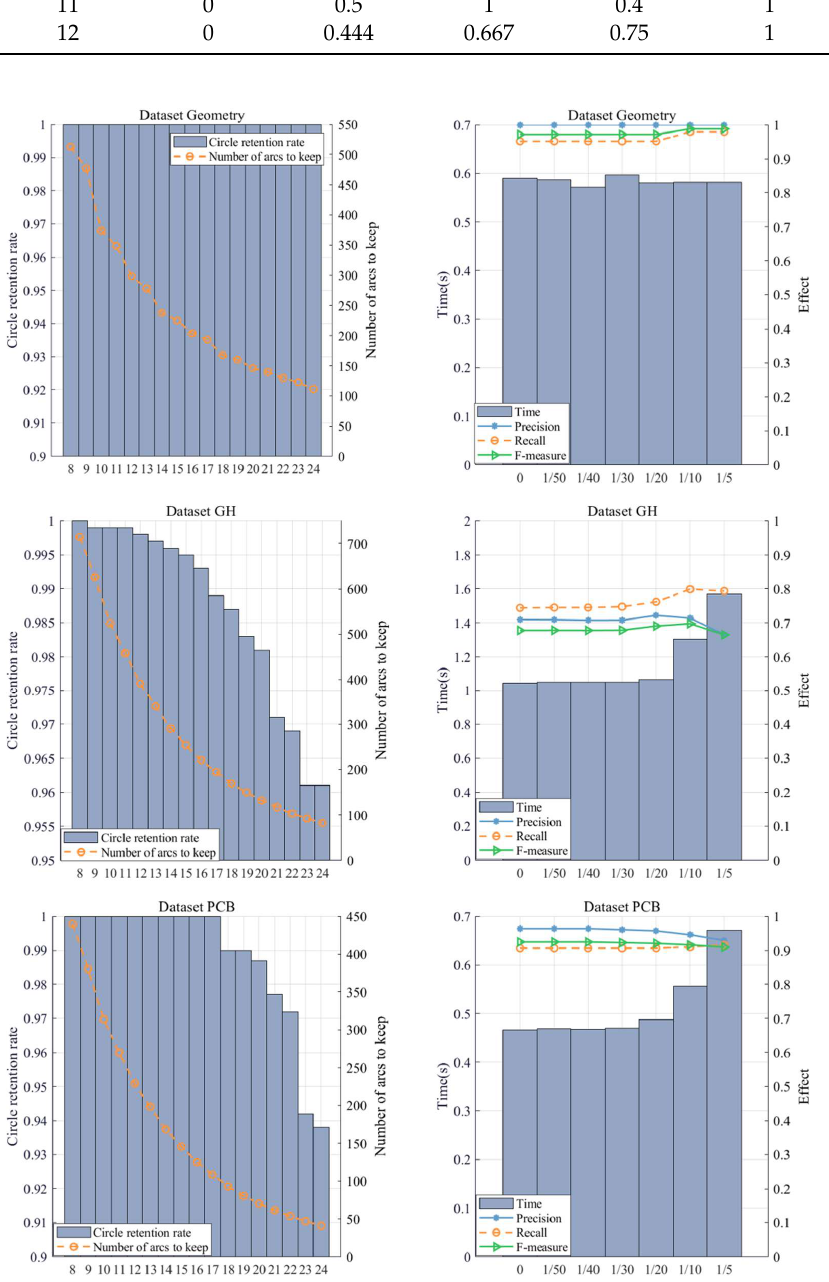
Figure 6. On the left is the threshold and intermediate result for parameter L, and on the right is the threshold and final result for parameter